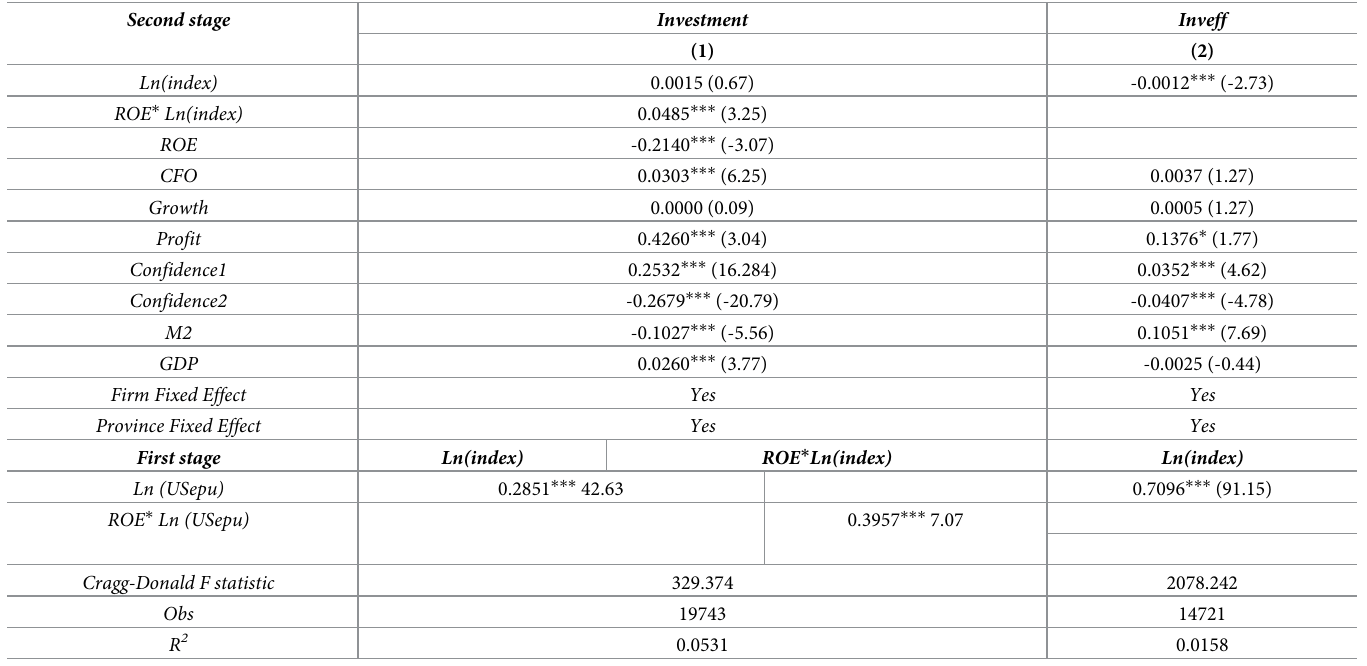
Table 10. Robustness check: Instrumental variable replaces the explained